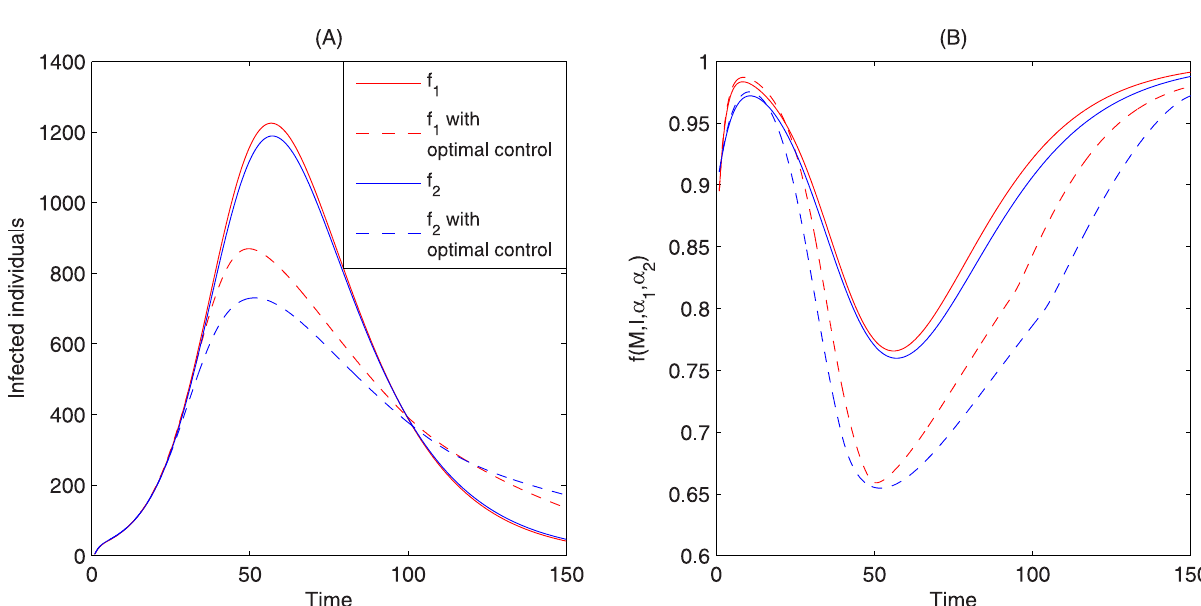
Fig 10. Optimal control solutions. (A) Comparison of numbers of infected individuals for system (1) and the optimal control system (4). The solid curves are solutions of the original system (1) while the dashed curves are solutions of the optimal control system (4). The red and blue colors represent the corresponding solutions by using media function f 1 and f 2 , respectively. (B) Comparison of two different media functions f 1 (red), f 2 (blue) before (solid) and after (dashed) optimal control.